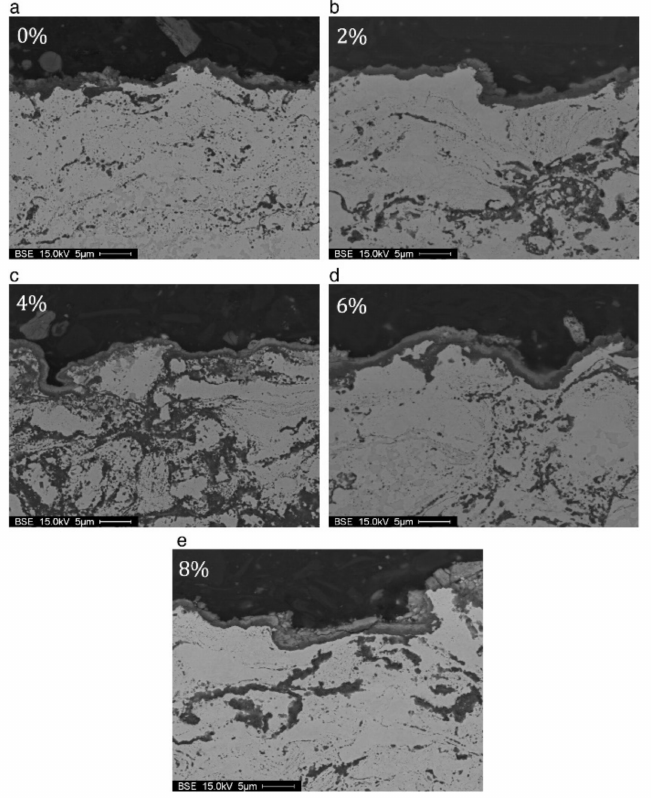
Figure 2. Backscattered electron micrographs of NiCoCrAlY coatings oxidized at 1000 ◦ C for 24 h in air with various vol.% vapor content [15]. ( a ) 0 vol.%; ( b ) 2 vol.%; ( c ) 4 vol.%; ( d ) 6 vol.%; ( e ) 8